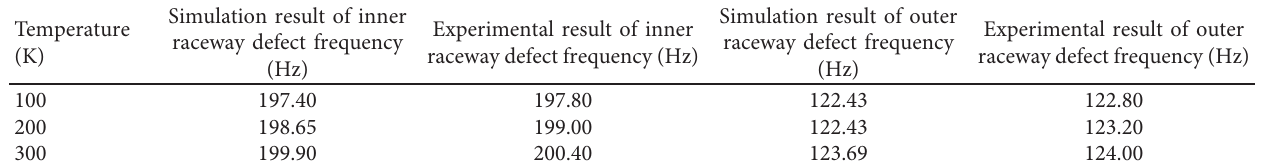
Table 5: Comparison between the simulation and experiment